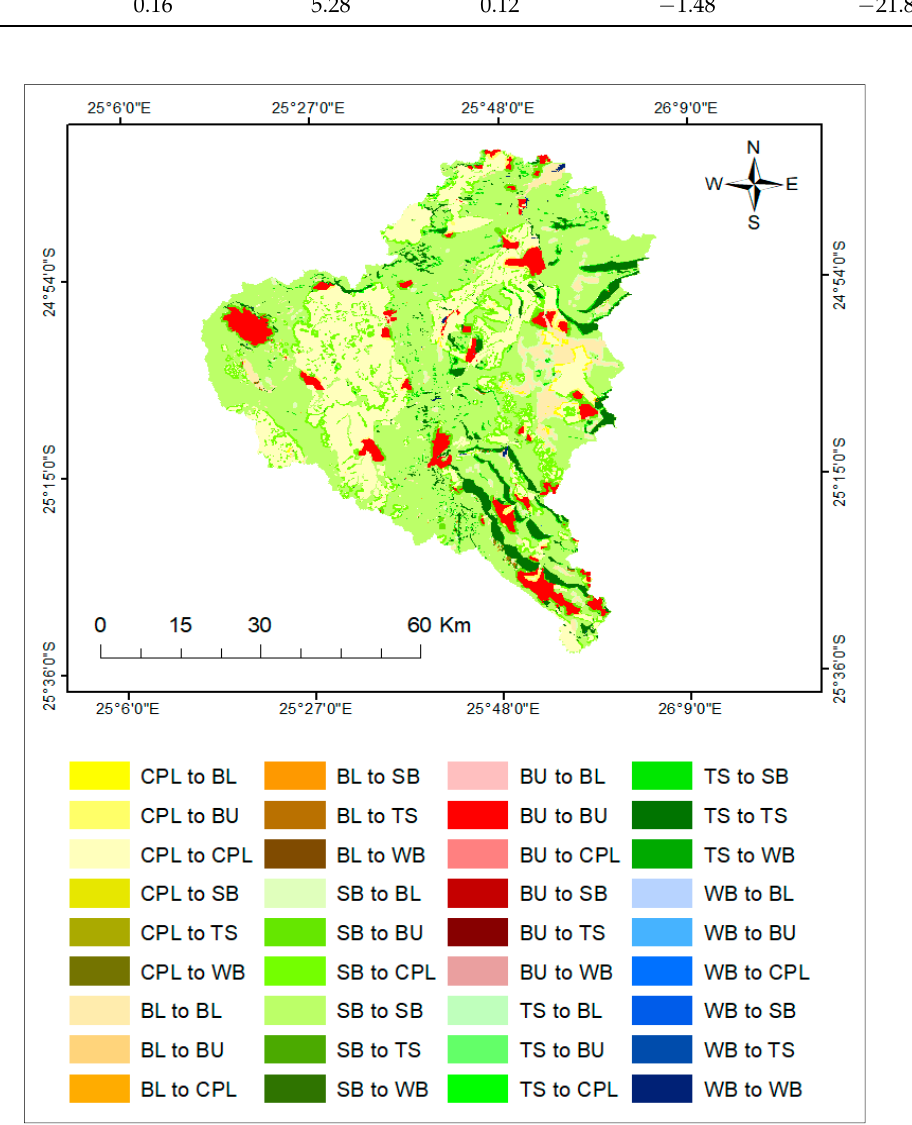
Figure 9. Projected losses and gains between 2015 and 2035. NB: CL—cropland, BL—bare land, SB;—shrubland, BU—built-up, TS—tree savanna, WB—water body.